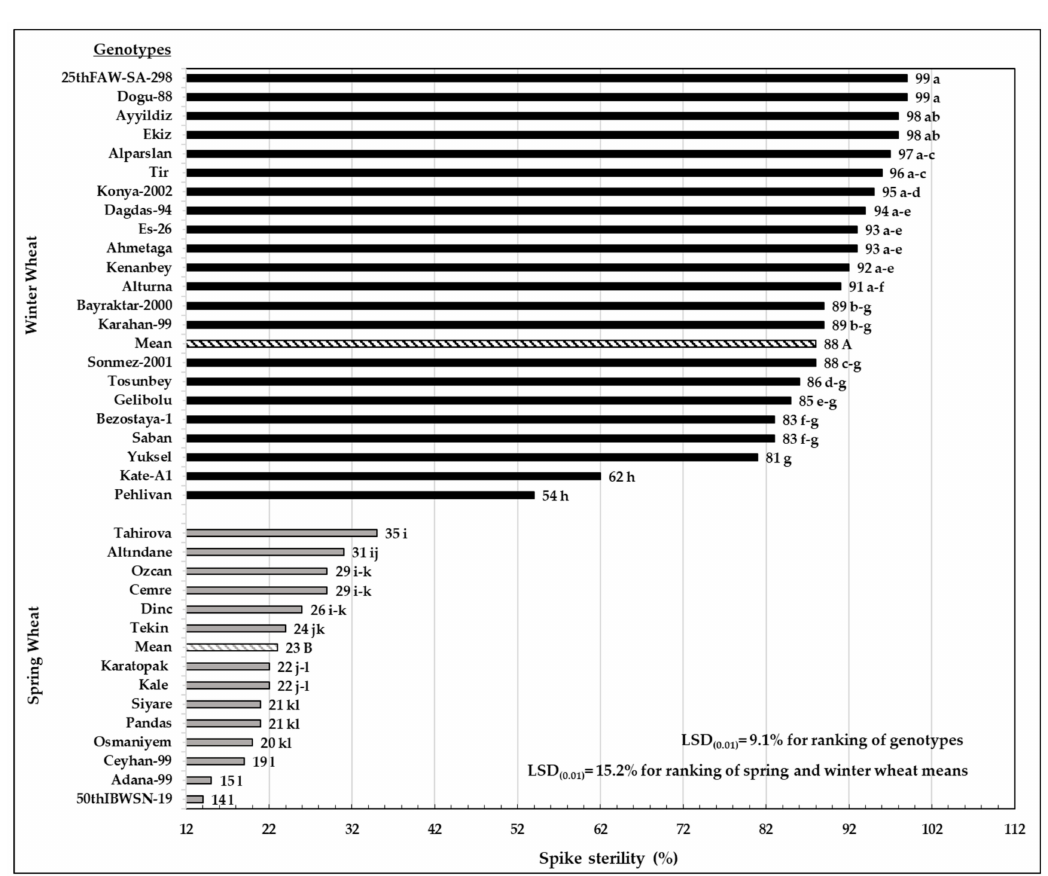
Figure 9. Comparing winter wheat genotypes with spring wheat genotypes for spike sterility (%) over two cropping seasons. Genotypes with the same letter are not significantly